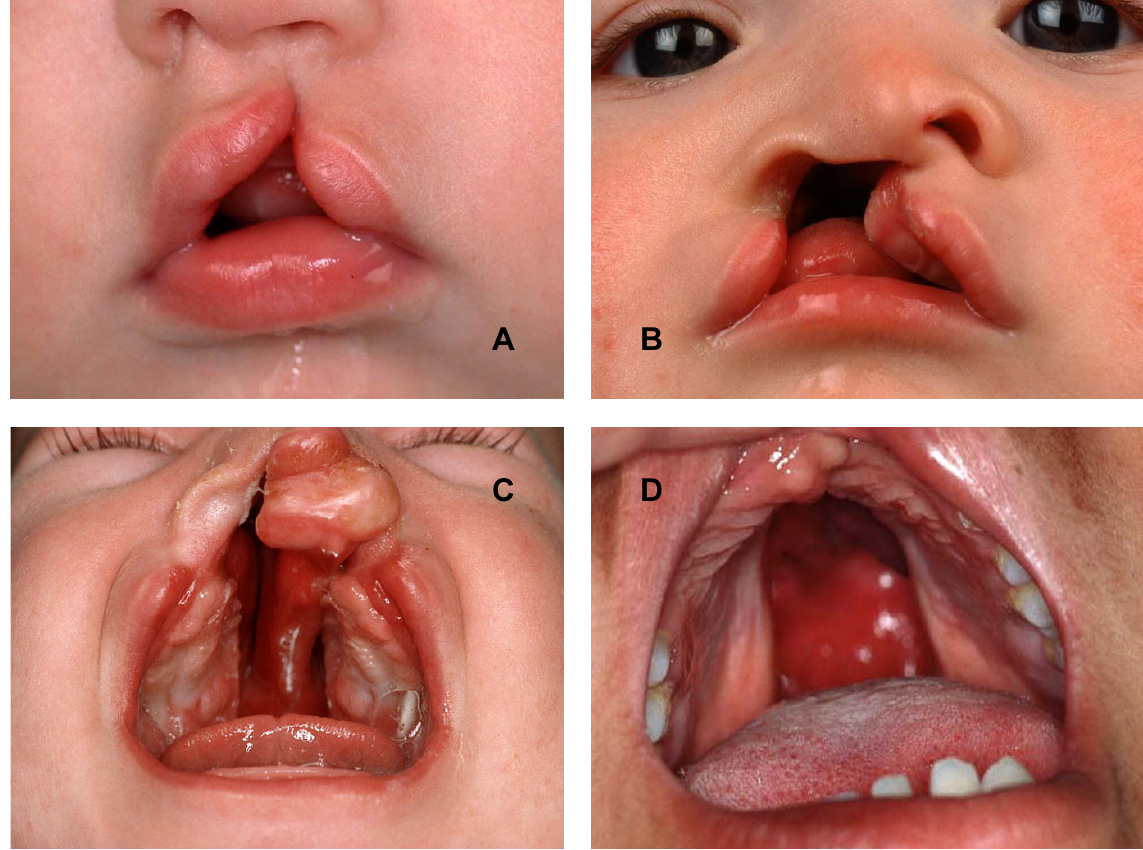
Figure 1 Patients with clefts: (A) incomplete unilateral cleft of the lip, (B) unilateral cleft of the lip, alveolus, and palate, (C) bilateral cleft of the lip, alveolus, and palate, (D) isolated (median) cleft